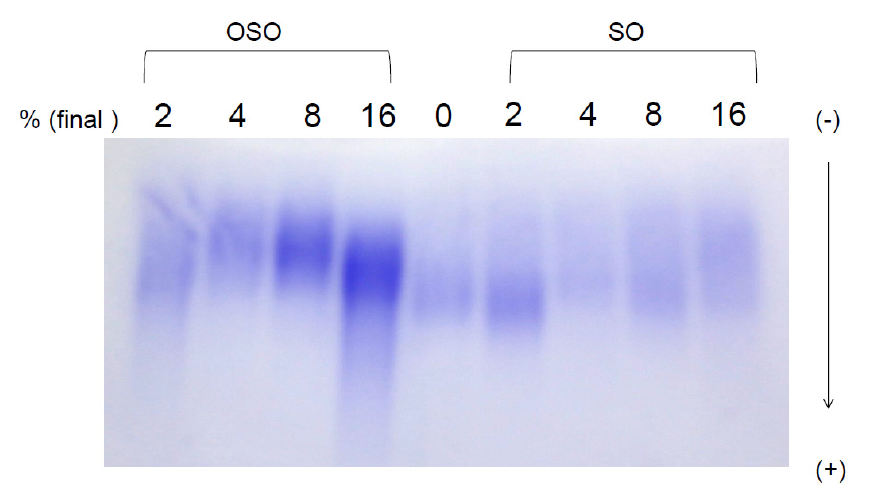
Figure 3. Electrophoretic profiles of HDL after incubation with OSO and SO (final 2, 6, 8, and 16%) for 72 h at 4 °C. The relative electrophoretic mobility was compared on 0.5% agarose gel, and the protein band was visualized by Coomassie blue staining. protein band was visualized by Coomassie blue